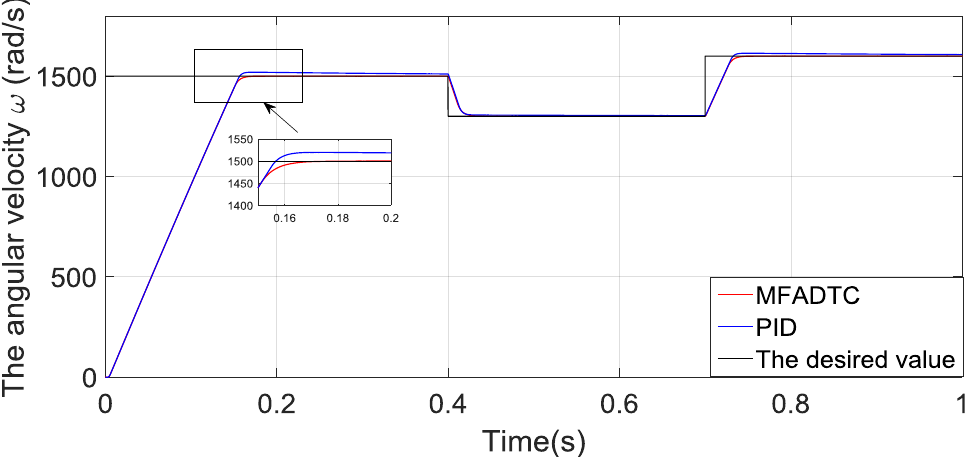
Figure 5. Comparison of tracking and adaptive capabilities between PID and MFADTC.